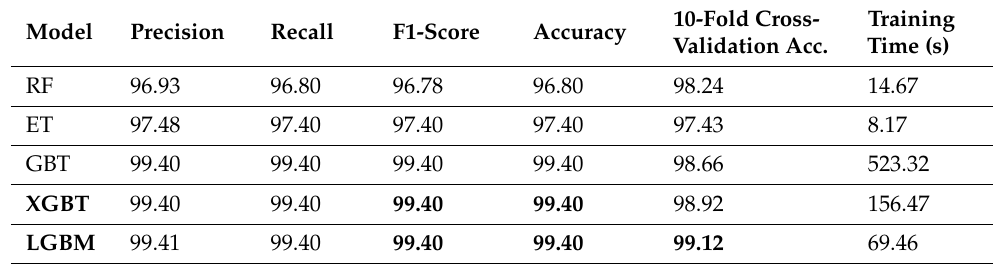
Table 10. Results on test set 120